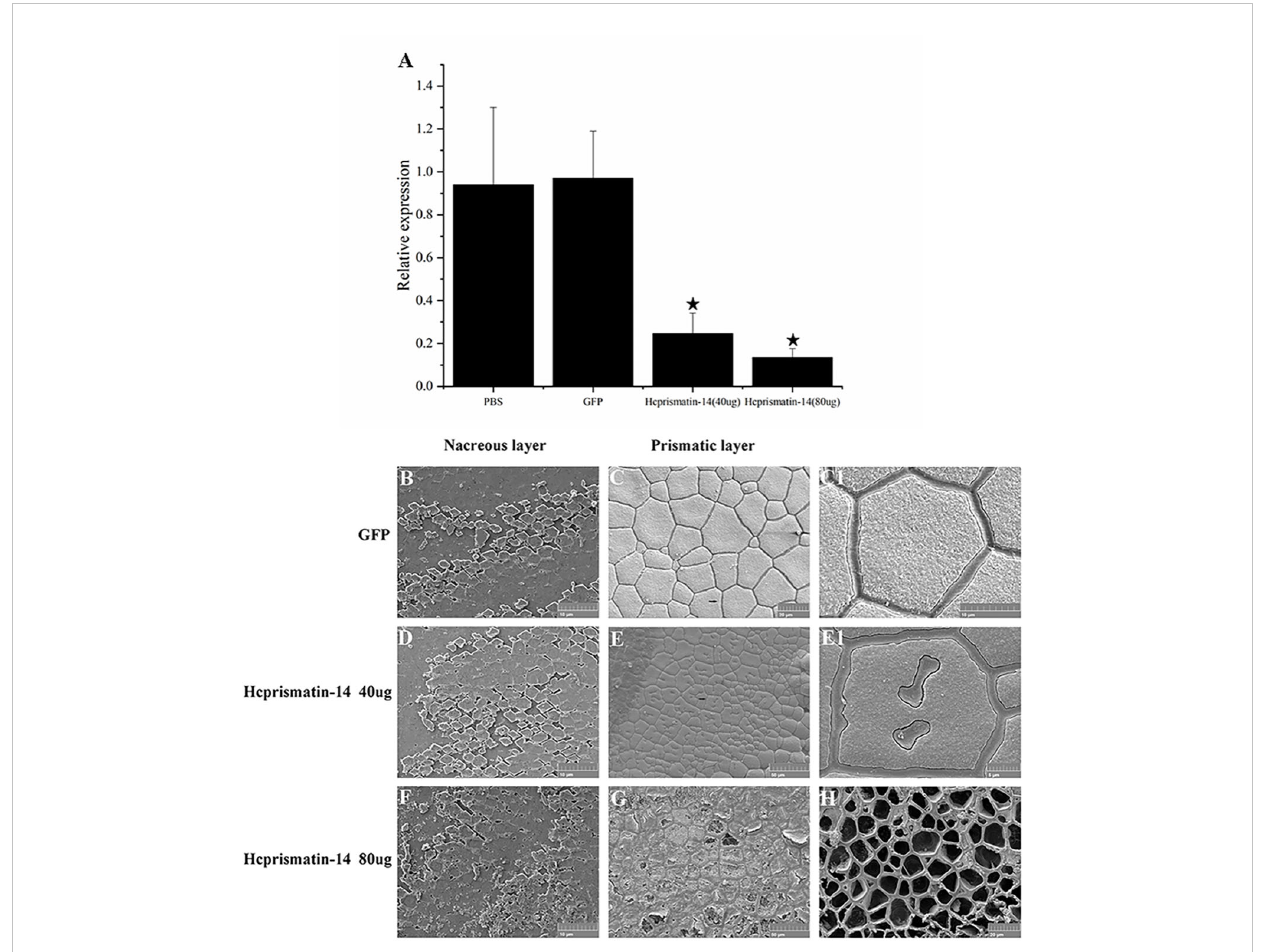
FIGURE 5 Knockdown of Hcprismatin-14 in RNAi assay. (A) , The relative expression of Hcprismatin-14 in mantle 7 days after injection, and the expression level in the PBS-injected group were attributed a relative value of 1.0; B – C1, Microstructure of shell inner surface in control groups. Scanning electron microscopy (SEM) observation of: (B) the nacreous layer in the control group characterized by a brick-wall structure comprising smooth aragonite and (C) prismatic layer in the control group characterized by the competitive growth of prisms with a smooth surface; (C1) enlargement of the arrow shown in (C) . D – E1, Microstructure of the shell inner surface in 40 m g/60 m L Hcprismatin-14-dsRNA injection groups. SEM observation of: (D) nacreous layer comprising smooth aragonite and (E) prismatic layer, in which irregular sinuous lacunae appear prominently in the center of mature prisms. (E1) Enlargement of the arrow shown in (E) ; F – H , Microstructure of shell inner surface in the 80 m g/60 m L Hcprismatin-14-dsRNA injection groups. SEM observation of: (F) nacreous layer comprising smooth aragonite and (G) prismatic layer, intra-column organic framework was destroyed, and the nano-sized subgrains became sparse and disordered in the center of prisms. (H) crystals have been either completely or nearly completely disappeared, leaving only thick polygonal organic